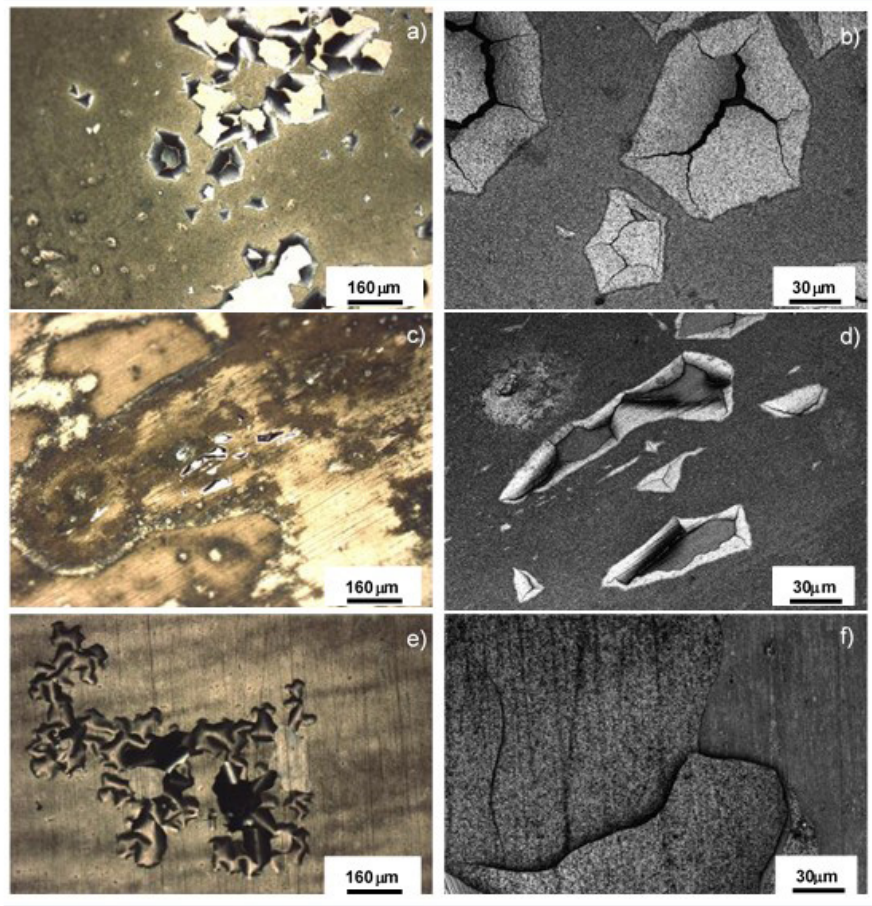
Figure 4. Optical (a, c, e) and laser scanning confocal microscope - LSCM (b, d, f) micrographs of several defects heterogeneously distributed on the oxide layer produced under air/steam/N atmosphere for each maraging alloy. 2 Table 4. Summary of the chemical composition determined by EDS measurements taken at different positions (see Figure 7c ). EDS quantitative analysis from points A, B and C (wt.%) Elem.